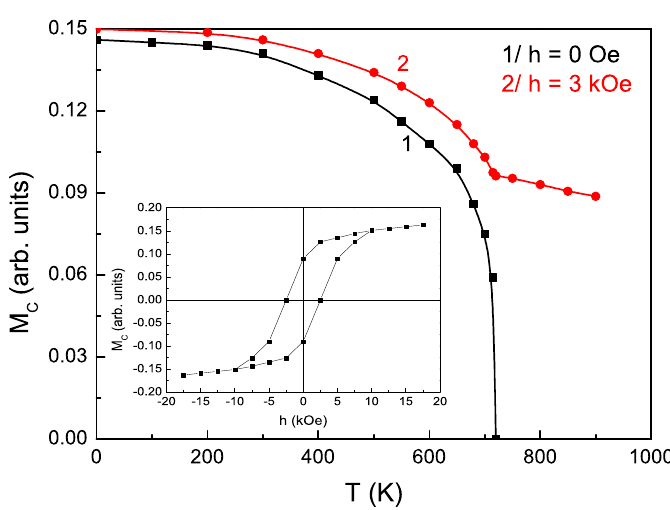
Figure 2. The temperature dependence of the magnetization M c , of the WFM of β -NFO for different magnetic fields h : (1) 0, (2) 3 kOe. Inset: Hysteresis loop of the magnetization M c for T = 600 K.